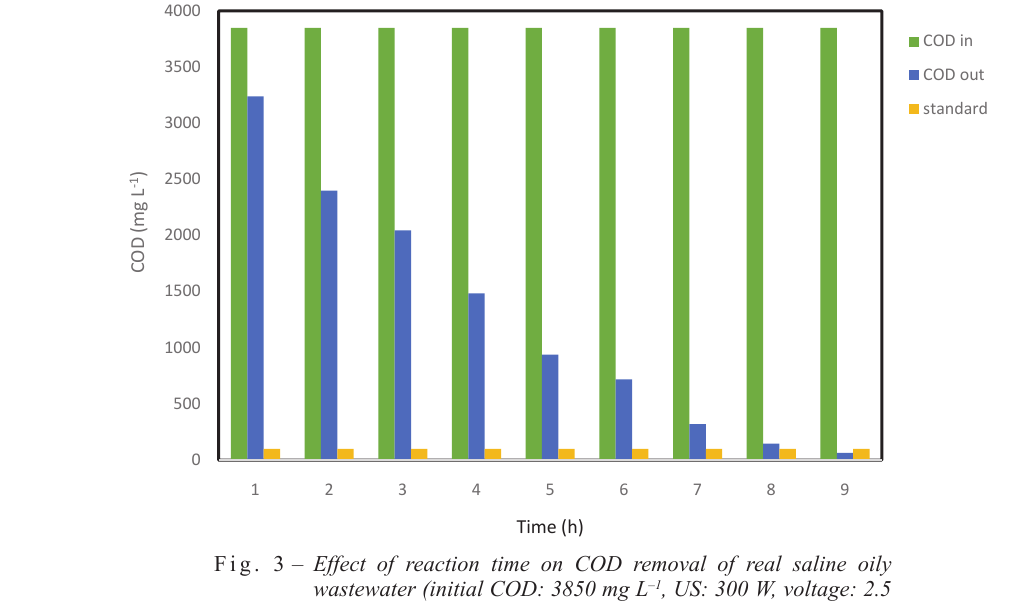
Fig. 3 – Effect of reaction time on COD removal of real saline oily wastewater (initial COD: 3850 mg L –1 , US: 300 W, voltage: 2.5 V, ED 8 cm, reaction time 9 h)